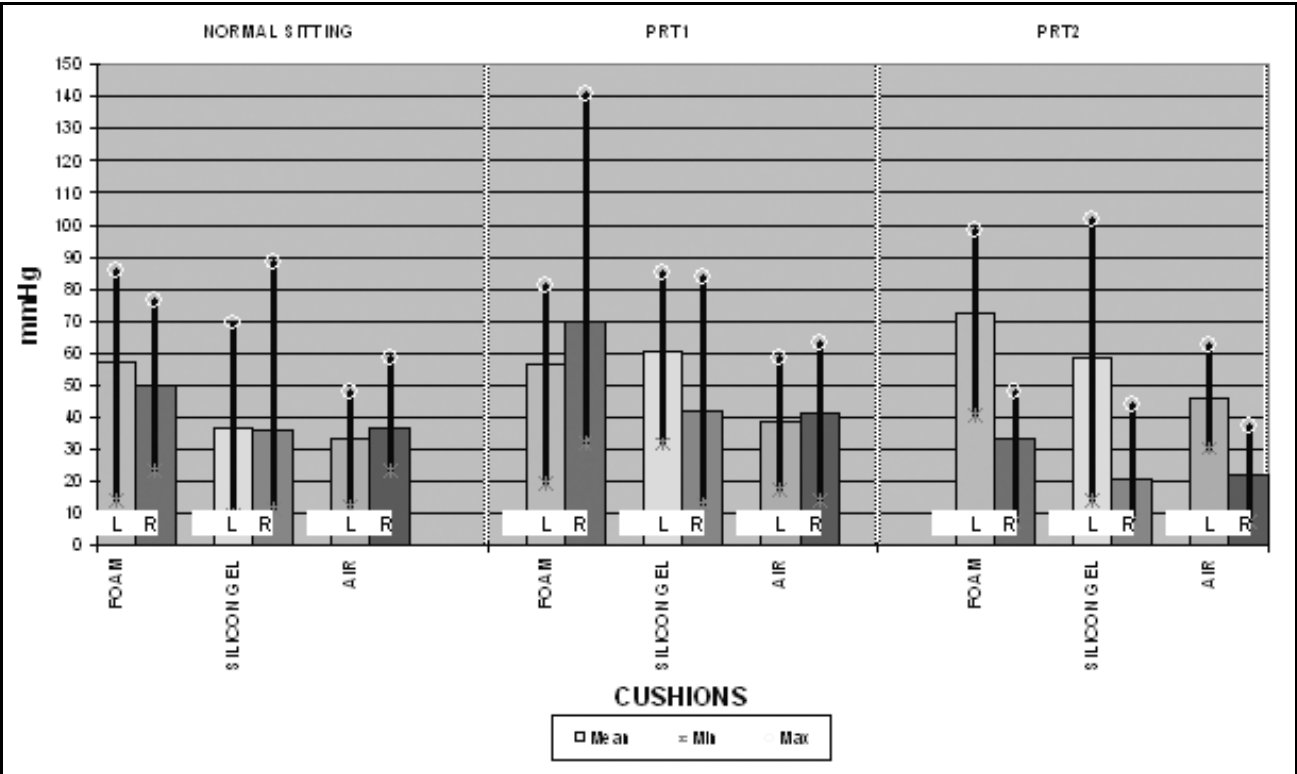
Figure 3: The six cells in matrices 2 and 4 that were situated over the uppr thigh regions on all 3 cushions in neutral sitting, PRT1 an